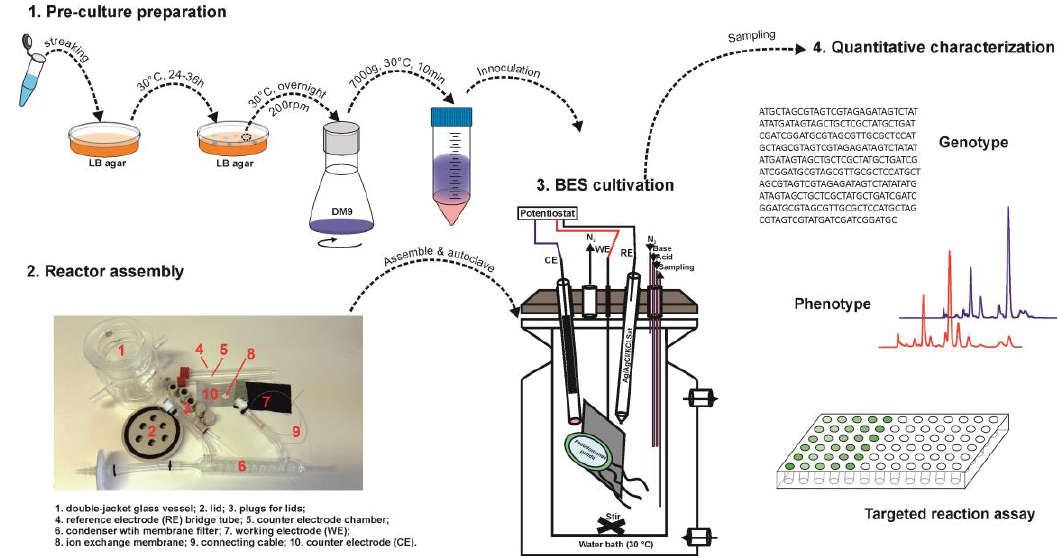
Figure 1. The general working flow for the cultivation and characterization of Pseudomonas putida in bioelectrochemical